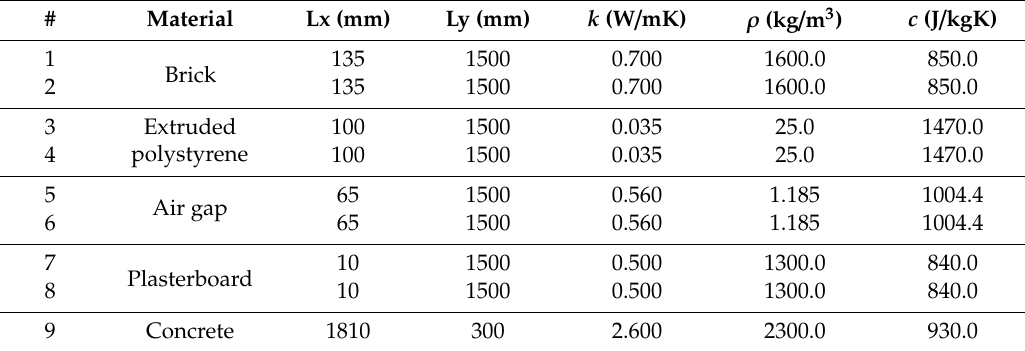
Figure 3. Geometry of model: ( a ) the entire wall (1–9 is the material number in Table 1); ( b ) the clear wall (external dimension system); ( c ) the clear wall (internal dimension system). Table 1. The material dimensions and thermal properties.